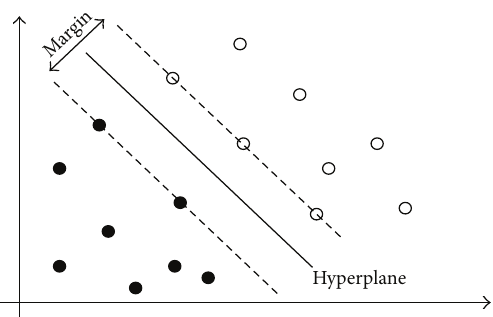
Figure 1: The optimal